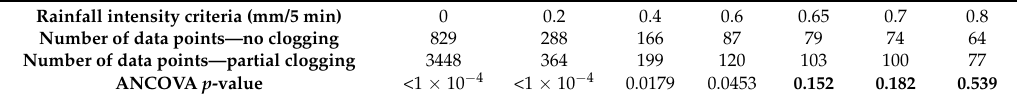
Table 1. ANCOVA results with different rainfall intensity thresholds below which data is excluded.